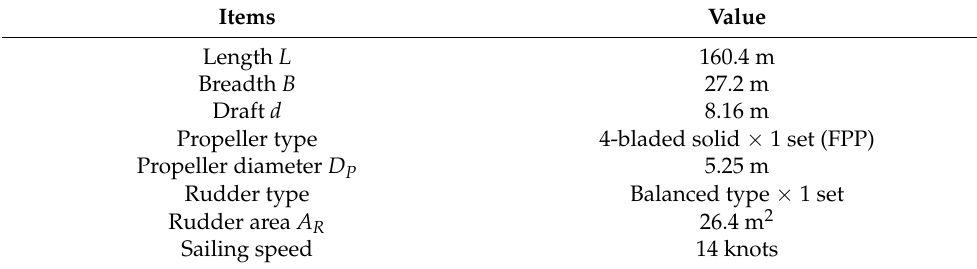
Table 1. Main particulars of the bulk